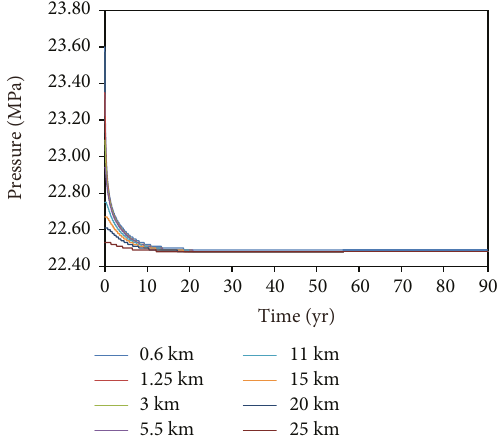
Figure 28: Pressure changes at the pressure monitoring points after injection in the 1-well model. cessation of CO 2